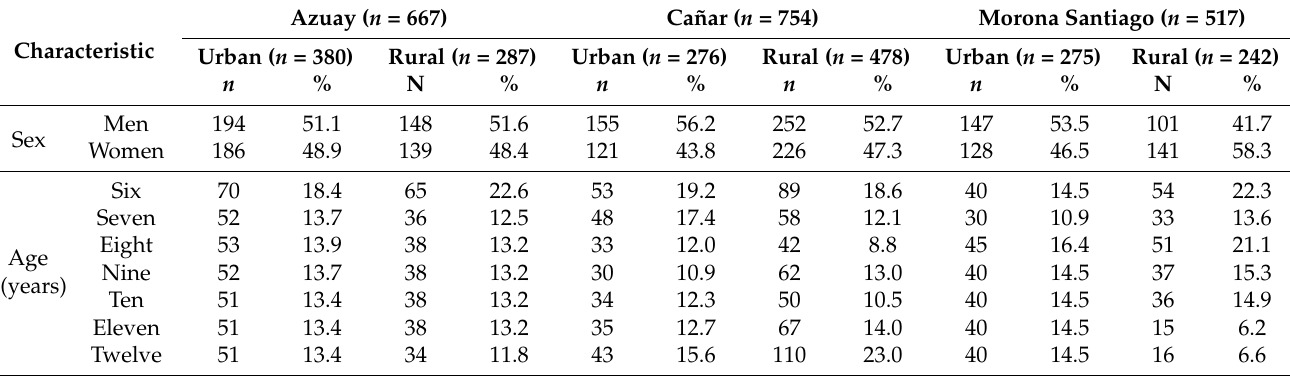
Table 1. Distribution of the population according to age, sex, and province.